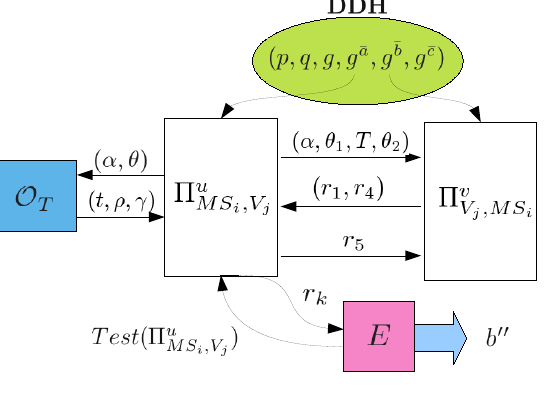
Figure 17. The proof model of Theorem